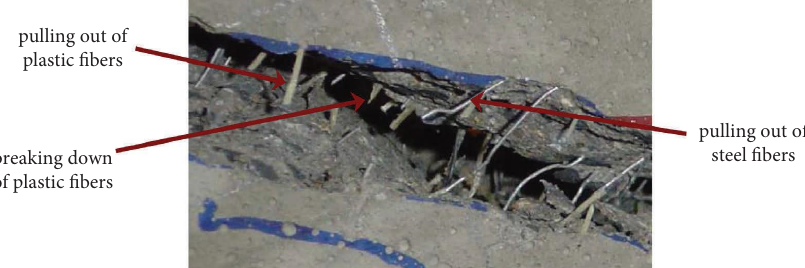
Figure 9: Pulling out of steel fber and breaking down of plastic fbers in hybrid fber-reinforced RC